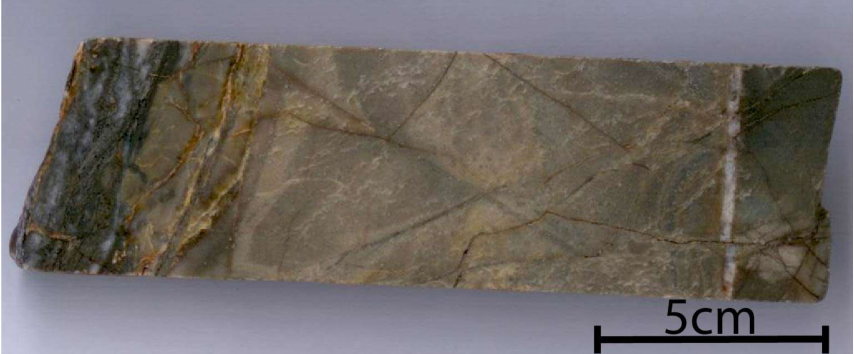
Figure9. Photographdisplayingaquartz–carbonatevein, roughly0.2cminwidth, whichiscross-cutting contact-metamorphosed (biotite-grade), and sericitically altered sedimentary rock. The diameter of the drill core is approximately 5 cm. Sample LG-48-4-143.5 was taken from Diamond Drill Hole (DDH) 78-4 at a depth of 143.5 feet (43.7